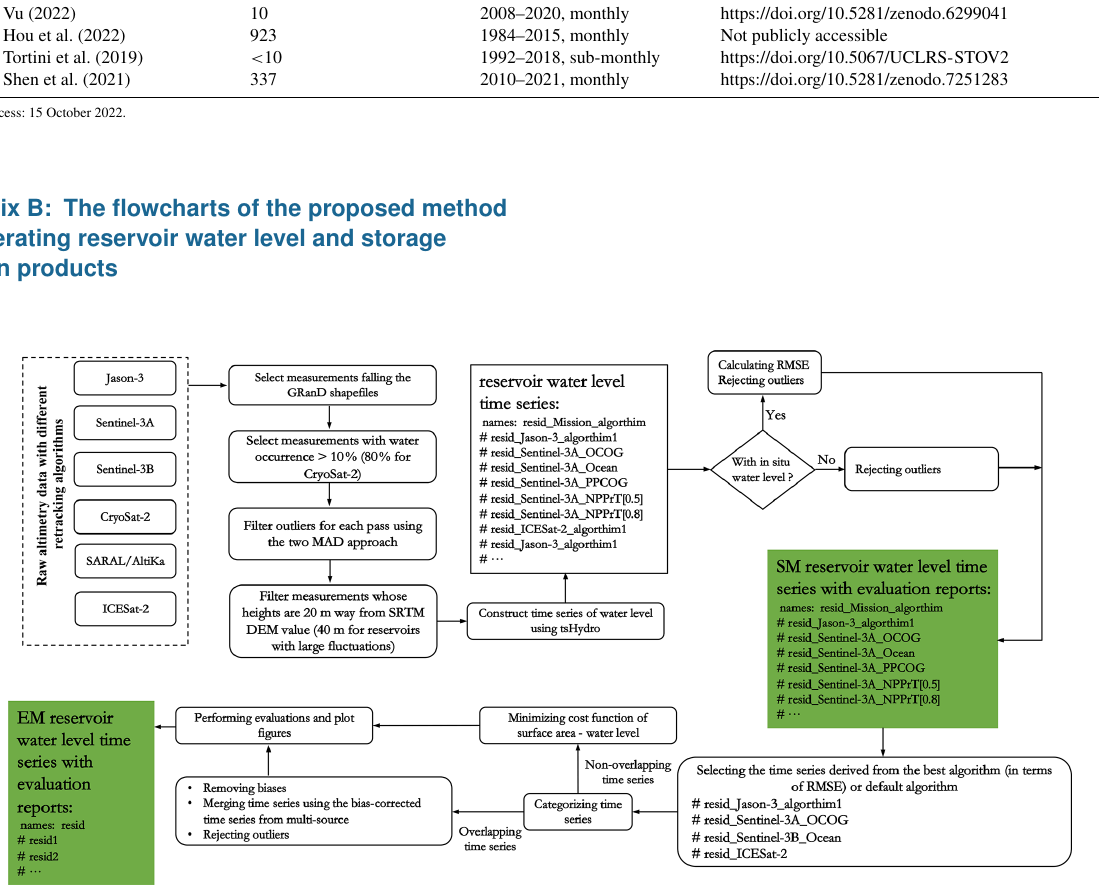
Figure B1. Flowchart of obtaining SM (standard-measurement) and EM (enhanced-measurement) altimetric water level time series over